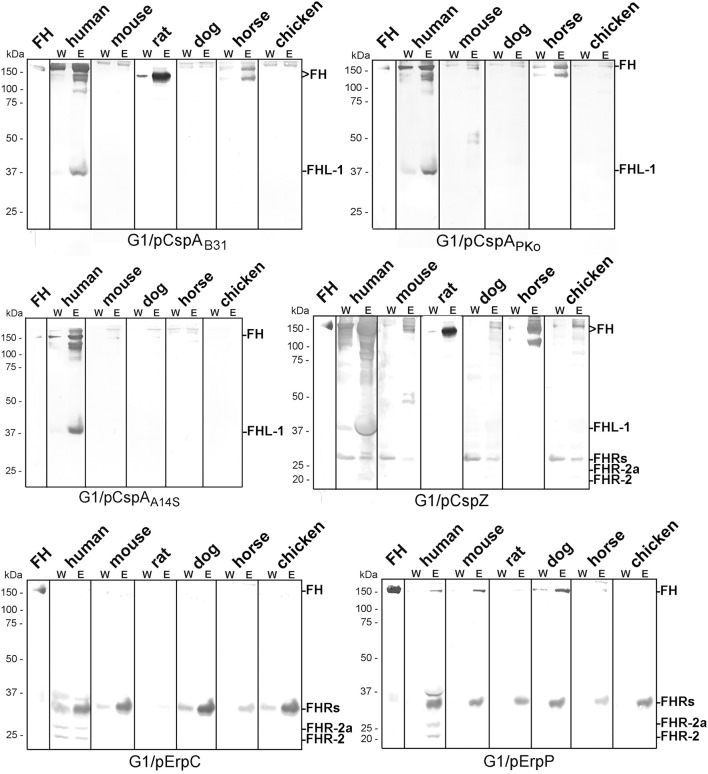
Identification of CRASP involved in binding of polymorphic FH molecules. Borrelia strains ectopically producing CspAB31, CspAPKo, CspAA14S, CspZ, ErpC, or ErpP were incubated in human serum and various animal sera. Following incubation, spirochetes were washed extensively and surface-bound proteins were eluted using 0.1 M glycine (pH 2.0). Both, the last wash (W) and the eluate (E) fractions obtained from each reaction were separated by glycine-SDS-PAGE under non-reducing conditions and transferred to nitrocellulose. FH molecules were detected by using a sheep anti-FH antibody (1:500). Purified human FH (500 ng) served as a control. The mobility of the molecular mass standard is indicated on the left of each panel.